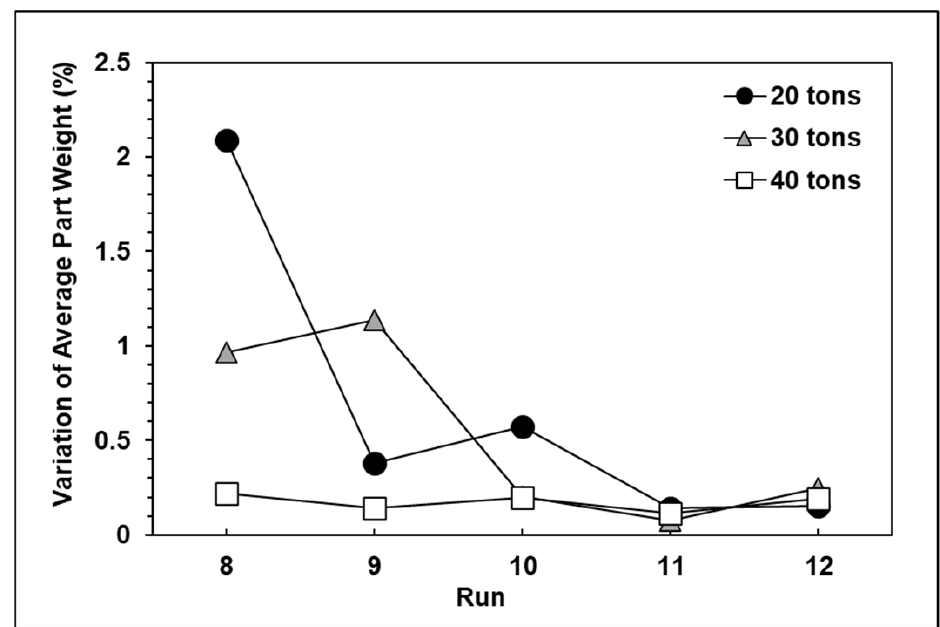
Figure 13. Variations in product weight under different amounts of clamping force.